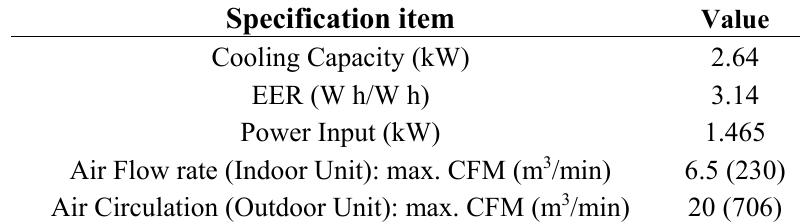
Table 8. Technical specifications of the air conditioners used in the simulation.